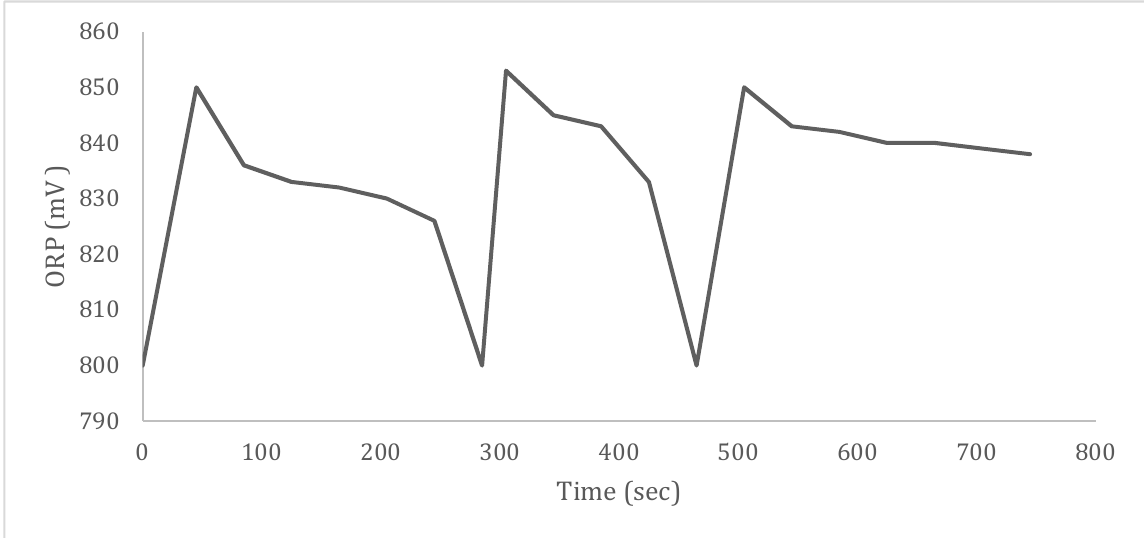
Figure 4. ORP change by starting and stopping ACD in closed-tube system.